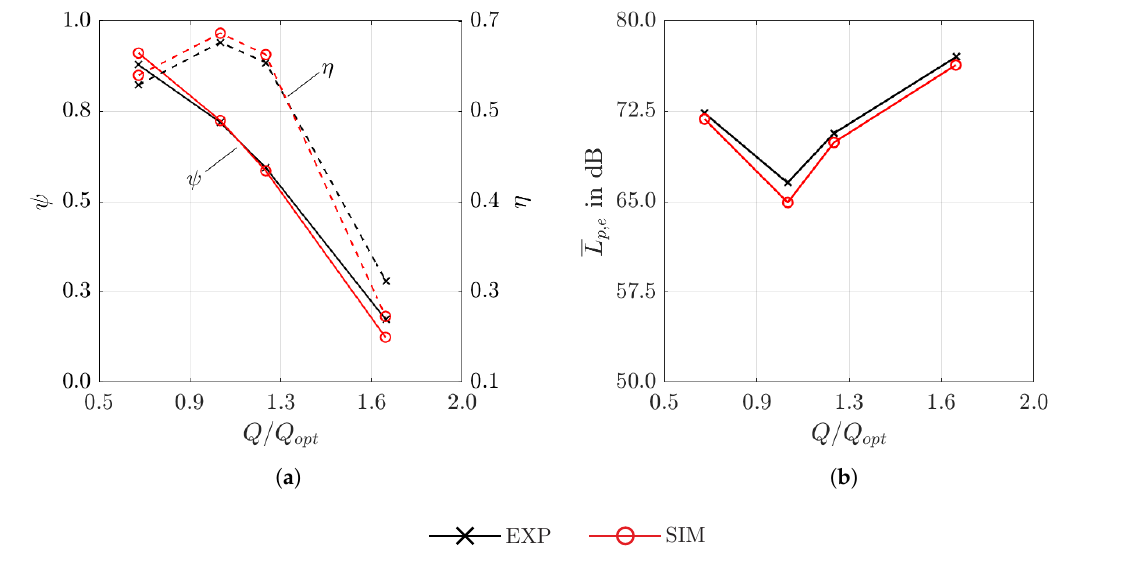
Figure 6. Pressure rise coefficient ψ and efficiency η ( a ) as well as total sound pressure L p , e ( b ) as function of volume flow rate Q / Q